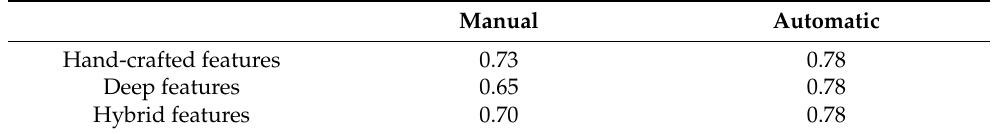
Table 3. Accuracy results of the survival prediction using the RF model, comparing manual and automatic contours. The model performances are given for the three types of features extracted: hand-crafted features (extracted using conventional radiomics), deep-learning features (extracted using a deep-learning algorithm), and hybrid features (obtained by concatenating the first two